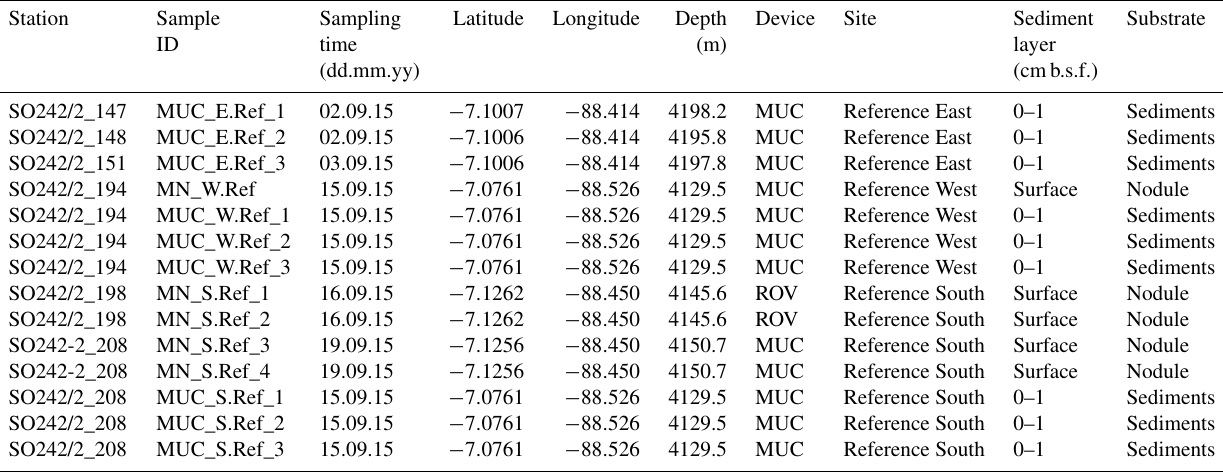
Table 1. Stations list and description of investigated sites/substrates. Station